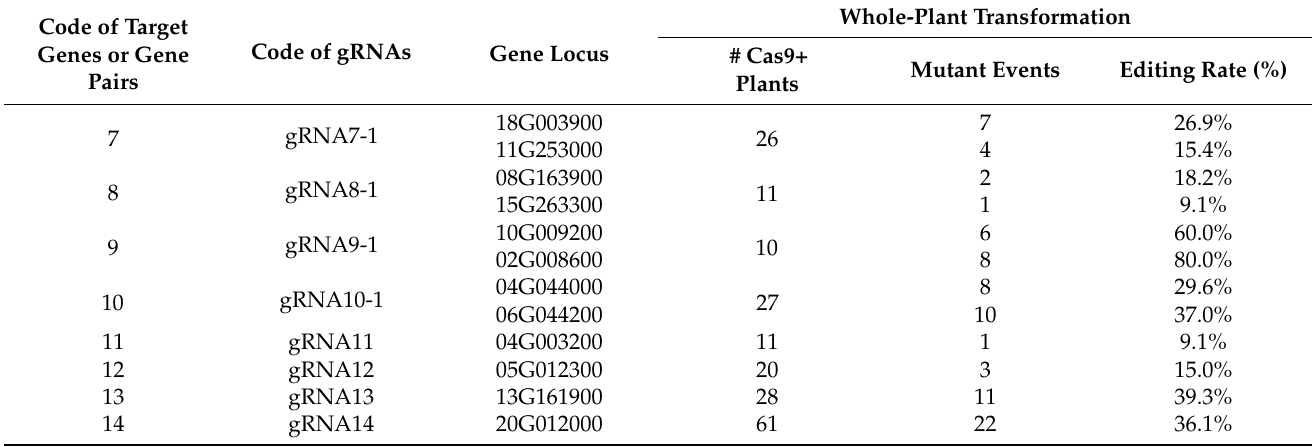
Table 5. Gene-editing efficiency of gRNA7-14 in whole-plant